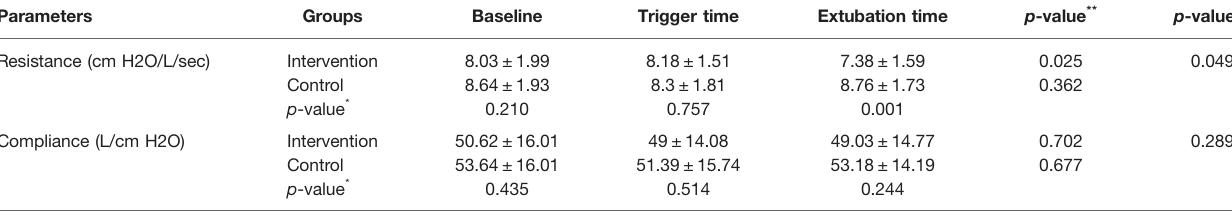
TABLE 4 | Comparison of airway resistance and compliance in different times between the intervention and control groups. Parameters